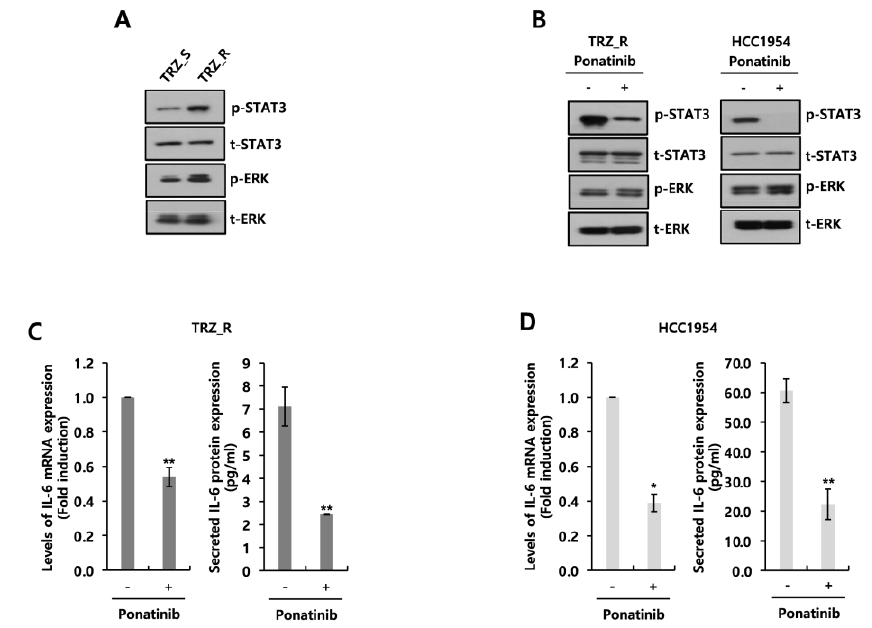
Figure 4. Ponatinib inhibits the PDGFC/PDGFR/STAT3 signaling pathway in the TRZ-resistant breast cancer cells. BT474 TRZ_R and HCC1954 cells were treated with 2 µ M ponatinib for 48 h. ( A , B ) Levels of t-STAT3, p-STAT3, and ERK protein in whole cell lysates were analyzed by Western blotting. ( C , D ) Levels of IL-6 mRNA (in whole cell lysates) and protein (in conditioned culture